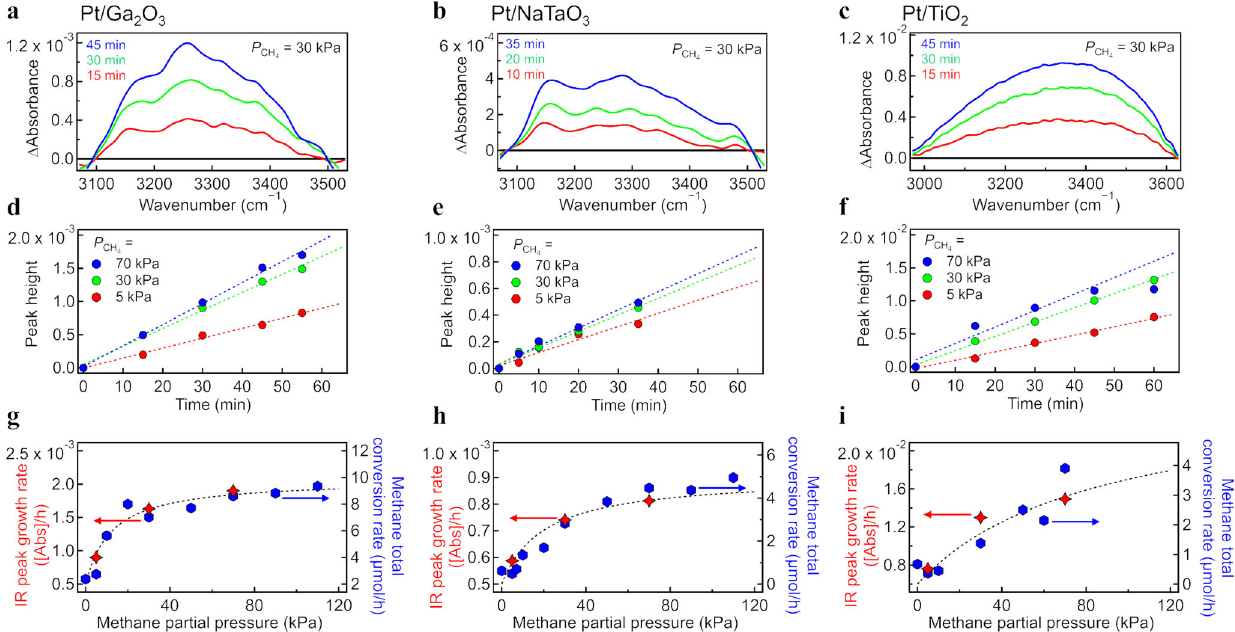
Fig. 2 Operando infrared (IR) spectroscopy of photocatalytic methane activation with isotope-labeled water (D 2 O). Time evolution of the IR spectra in the O – H stretching region for the a Pt/Ga 2 O 3 , b Pt/NaTaO 3 , and c Pt/TiO 2 photocatalysts under ultraviolet irradiation at a CH 4 pressure of 30 kPa under wet conditions (2 kPa of D 2 O). The operando IR measurements were started from the time when the temperature increase leveled off in order to extract the response derived from photocatalytic reaction while excluding the spectral change derived from the sample heating (see Supplementary Note 9 for details). Time zero ( t = 0 min) was de fi ned as the starting time for the IR measurement. Time evolution of the peak height at 3250 cm – 1 for the d Pt/Ga 2 O 3 , e Pt/ NaTaO 3 , and f Pt/TiO 2 photocatalysts at CH 4 pressures of 5, 30, 70 kPa. Growth rate of the peak at 3250 cm – 1 (left axis) and CH 4 total conversion rate (right axis) on the g Pt/Ga 2 O 3 , h Pt/NaTaO 3 , and ( i ) Pt/TiO 2